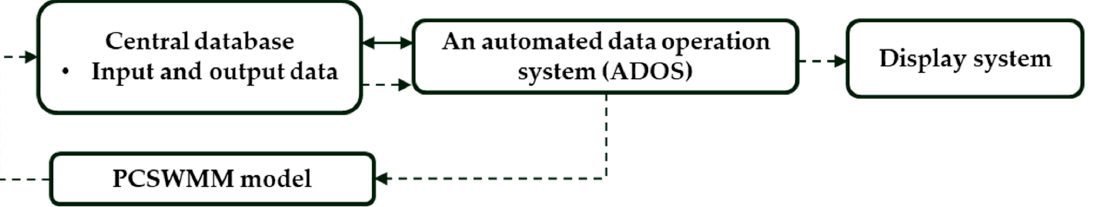
Figure 6. The flowchart of an automated data operation system (ADOS).